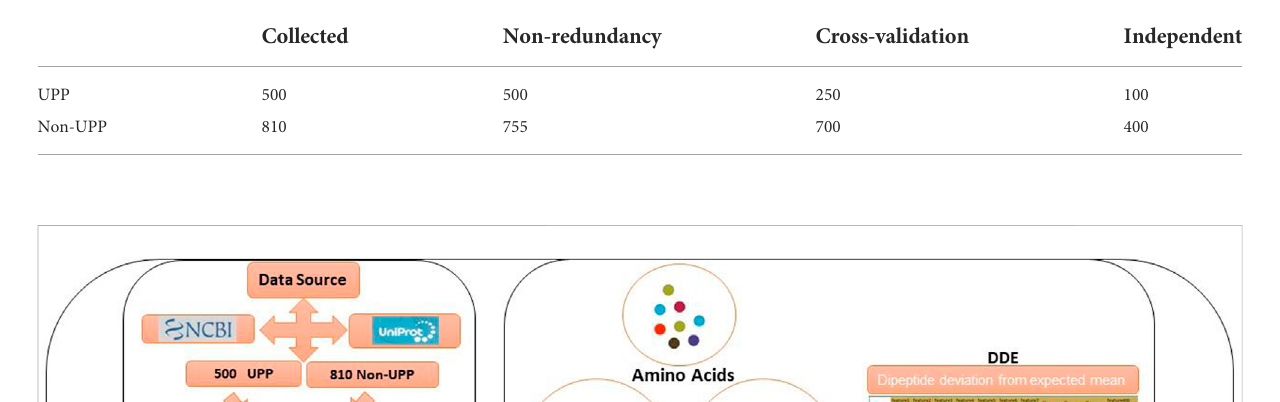
TABLE 1 Sample for this experimental data points collected UPP and non-UPP